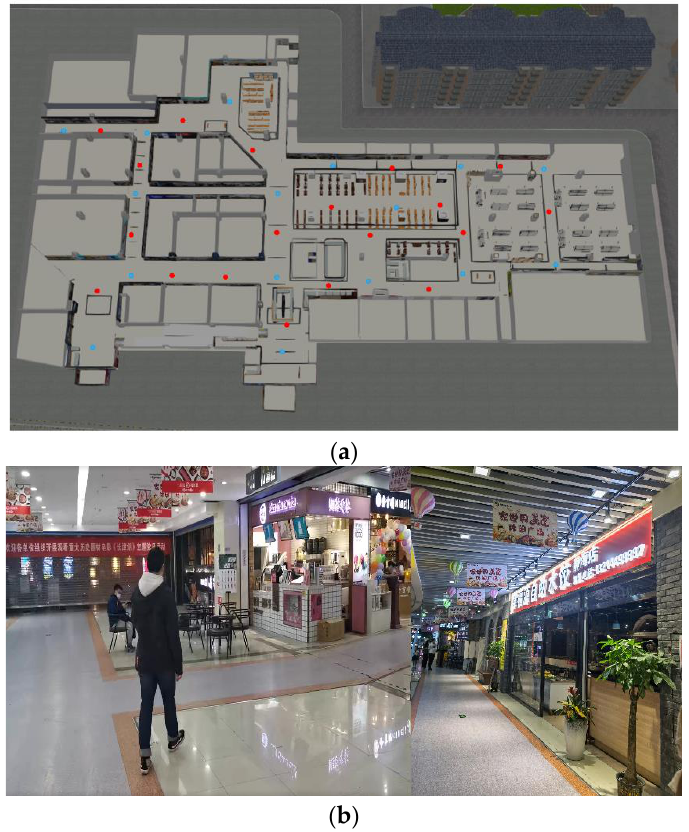
Figure 12. Test scenario. ( a ) is floor plan of the mall. The blue point is the location of the communication-positioning integrated base station, and the red point represents the test point. ( b ) is a photograph of the test scenario.